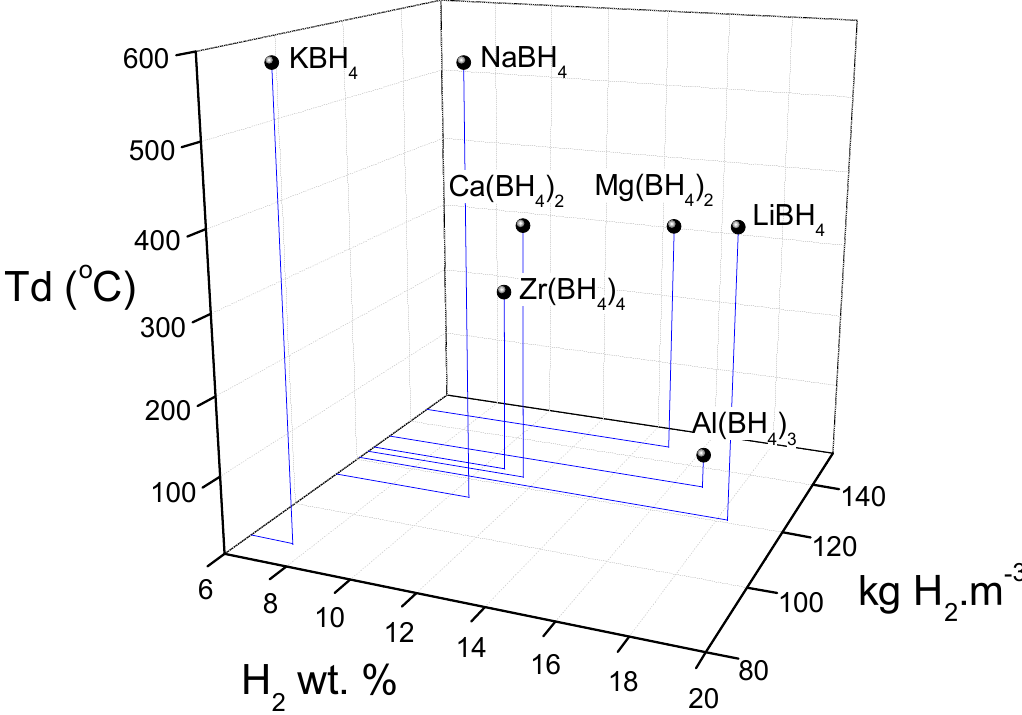
Figure 1. Hydrogen gravimetric capacity (wt.%), volumetric capacity (kg H 2 · m − 3 ), and decomposition temperature (Td) of alkali, alkali earth, Zr, and Al borohydrides.